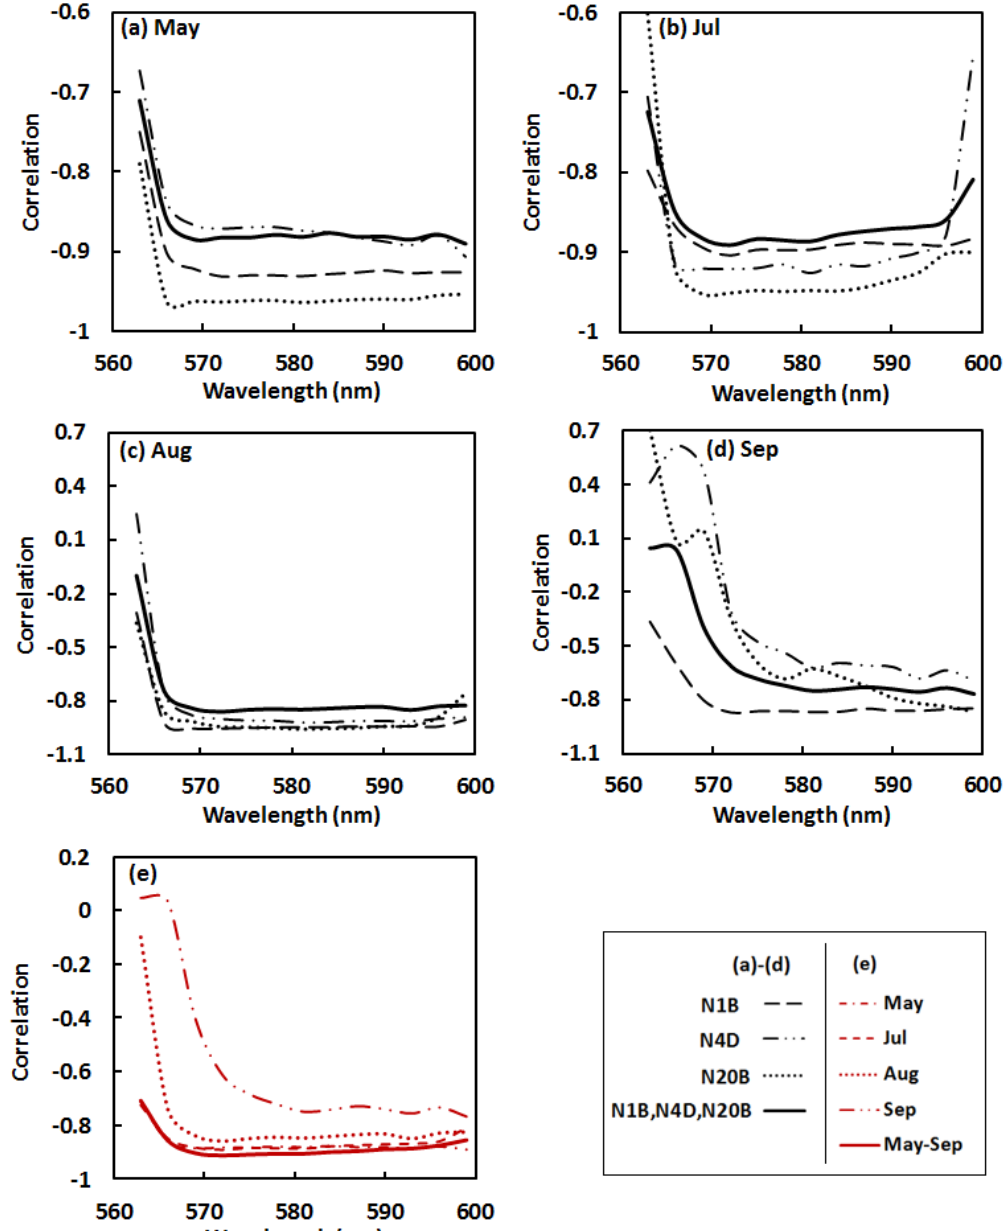
Figure 5. Correlations between canopy nitrogen and the continuum removed spectra at the wavelengths of 562–600 nm for three watersheds N1B, N4D and N20B respectively and as a whole in ( a ) May, ( b ) July, ( c ) August, ( d ) September, and for ( e ) four months respectively and the whole growing seasons in May–September across various